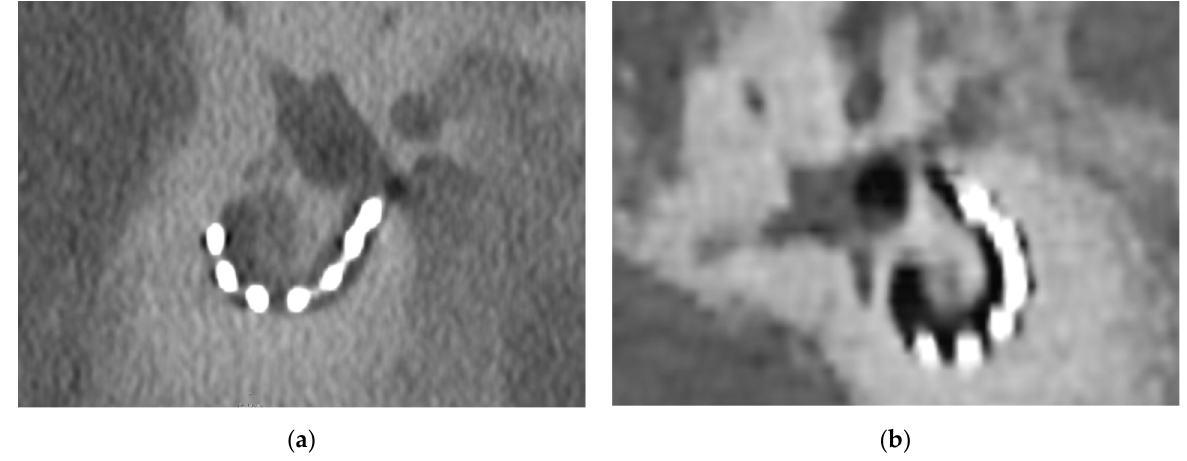
Figure 2. Comparison of the visibility of an implanted CI and the surrounding temporal bone. ( a ) PCD-CT image of CI following implantation surgery at 160 kV; ( b ) EID-CT image of CI following implantation surgery at 160 kV. The metal-to-bone contrast is better for the PCD-CT images.